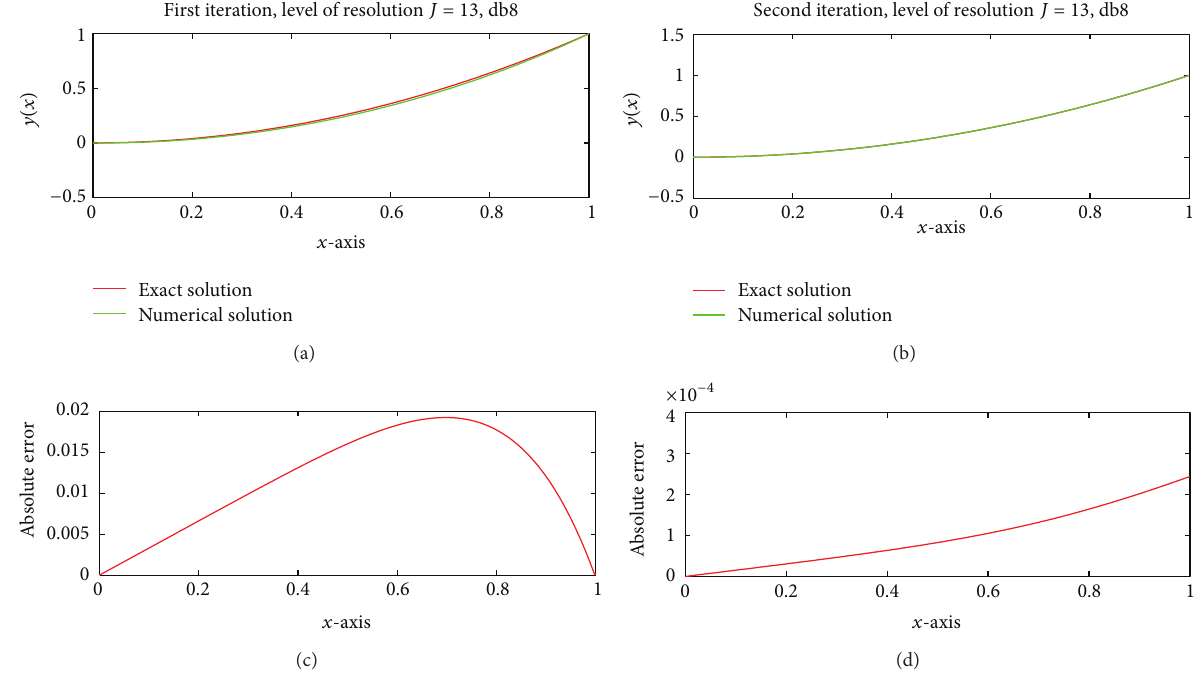
Figure 1: Comparison of exact solution and solution by wavelet-Galerkin method with quasilinearization technique at 𝐽 = 13 , for different iterations, and we used 𝐷16 .